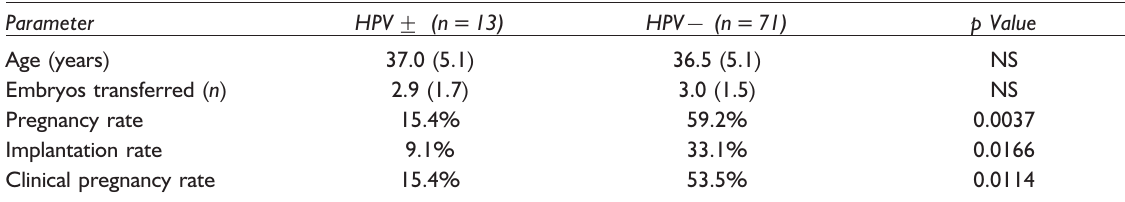
Table 1 Relation between HPV detection and IVF